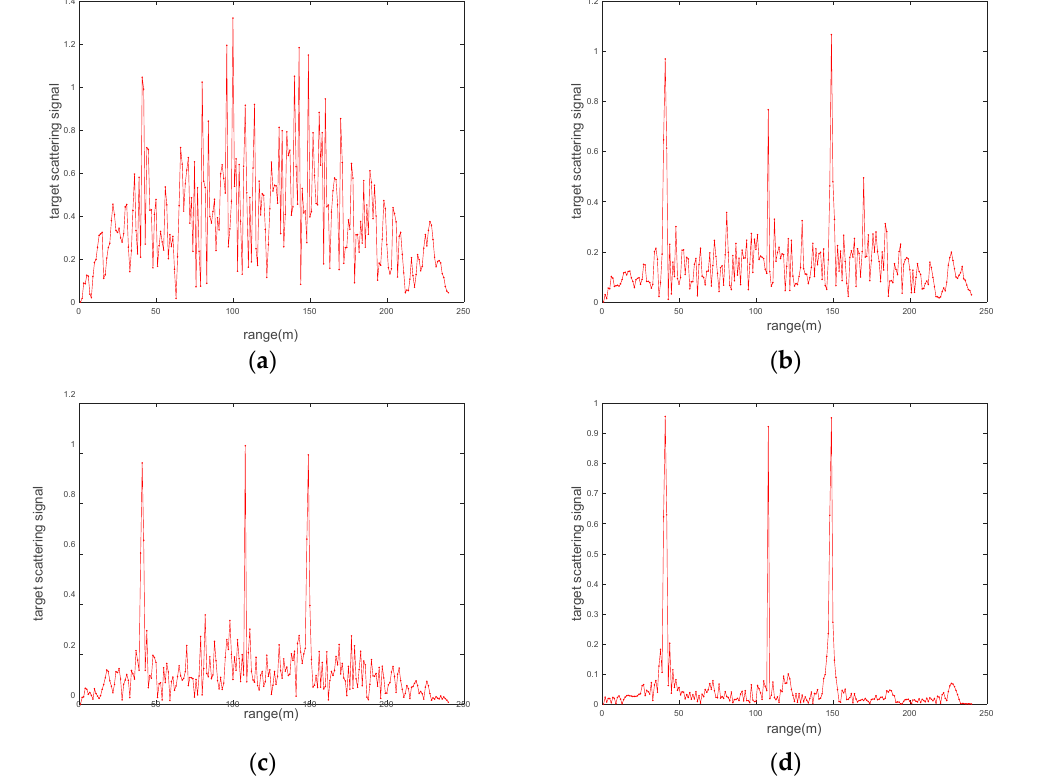
Figure 9. Target-scattering signal profiles at ( a ) iteration 1, ( b ) iteration 5, ( c ) iteration 10, and ( d ) iteration 20.